Question: According to the figure, is the described quantity increasing or decreasing?
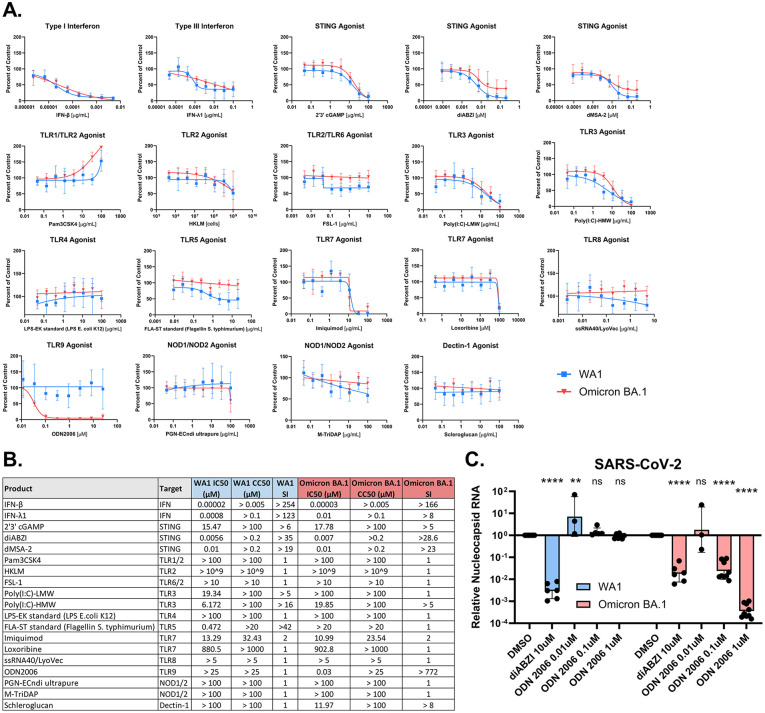
Answer: increasing